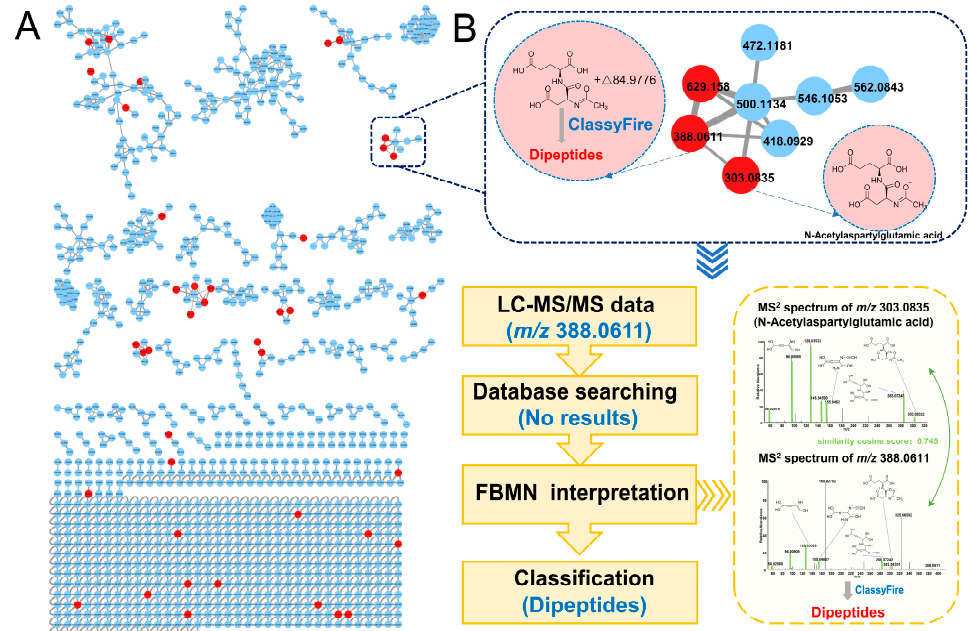
Figure 4. ( A ) FBMN of hippocampal tissue in negative ion mode using the RP column; ( B ) an example of annotation pipeline of the feature ( m/z 388.0611) by FBMN. (The differential features are colored in red, the m/z of each feature is displayed at the center of the nodes, and the width of the edges show the magnitude of the cosine score, FBMN: feature-based molecular networking).